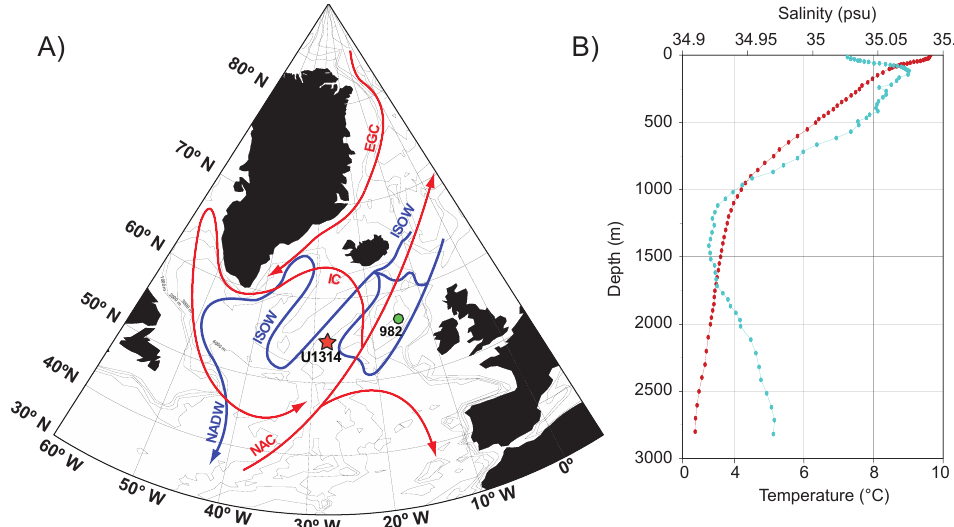
Figure 1. (a) Location of IODP Site U1314. Modern surface (red), and deep circulation (blue) in the North Atlantic: East Greenland Current (EGC), North Atlantic Current (NAC), Irminger Current (IC), Iceland–Scotland Overflow Water (ISOW), North Atlantic Deep Water (NADW). (b) Plots of temperature ( ◦ C, red) and salinity (PSU, blue) versus depth obtained from the World Ocean Atlas 2013 (Locarnini et al., 2013; Zweng et al., 2013). Map generated with Ocean Data View v.3.4.3. software (Schlitzer,